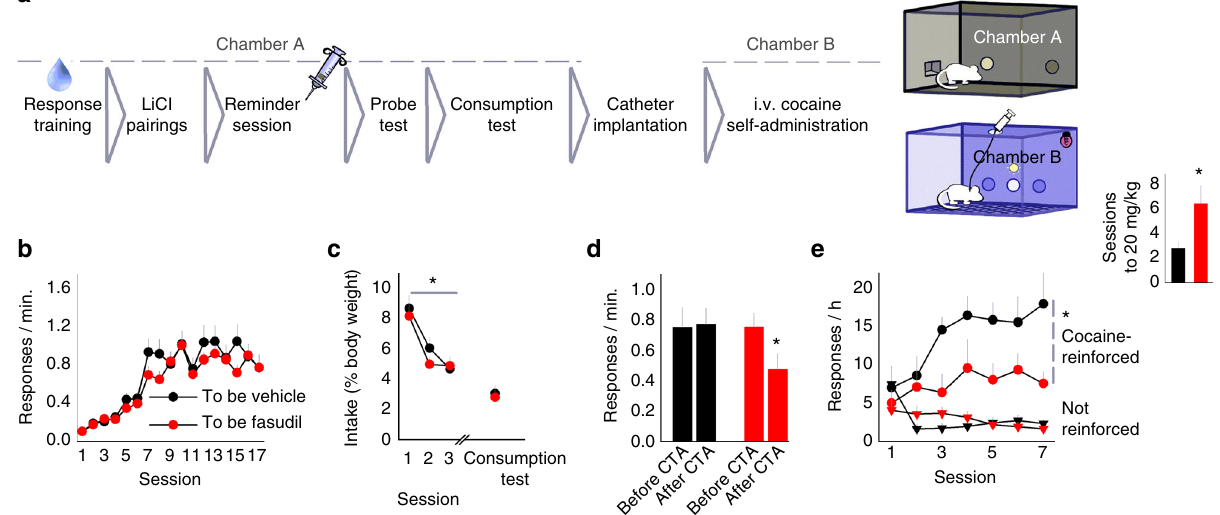
Fig. 5 ROCK inhibition blocks habitual responding for cocaine. a Experimental timeline: Mice were trained to respond for an orally ingested cocaine – sucrose solution. Then, mice were subject to LiCl-induced CTA. Mice were then placed in the conditioning chambers for a brief “ reminder session, ” which served as an opportunity for mice to update the association between the now-devalued outcome and responding. Mice were administered either vehicle or fasudil, followed by a probe test and fi nally, a post-probe consumption test. These mice were then implanted with indwelling jugular catheters for i.v. cocaine self- administration in contextually distinct conditioning chambers. b All mice responded for the cocaine – sucrose solution, without differences between groups ( n = 15, 18 per group). c During CTA, consumption diminished. d During a probe test, however, vehicle-treated mice did not reduce responding, despite CTA, indicating insensitivity to the now-reduced value of the cocaine reinforcer. In contrast, fasudil-treated mice reduced responding, indicating sensitivity to outcome value. e Mice were trained in contextually distinct chambers to self-administer i.v.-delivered cocaine. Although all mice ultimately acquired the response, mice with a prior history of fasudil treatment responded less throughout and required more sessions to ingest 20 mg/kg (inset). This outcome indicates that fasudil enhanced sensitivity to devaluation of the cocaine reinforcer, and not simply the sucrose that was part of the orally ingested solution. Bars and symbols = means+ s.e.m., * p < 0.05. Three cohorts of mice were tested. We thank A. Allen for generating the illustration used in this fi gure